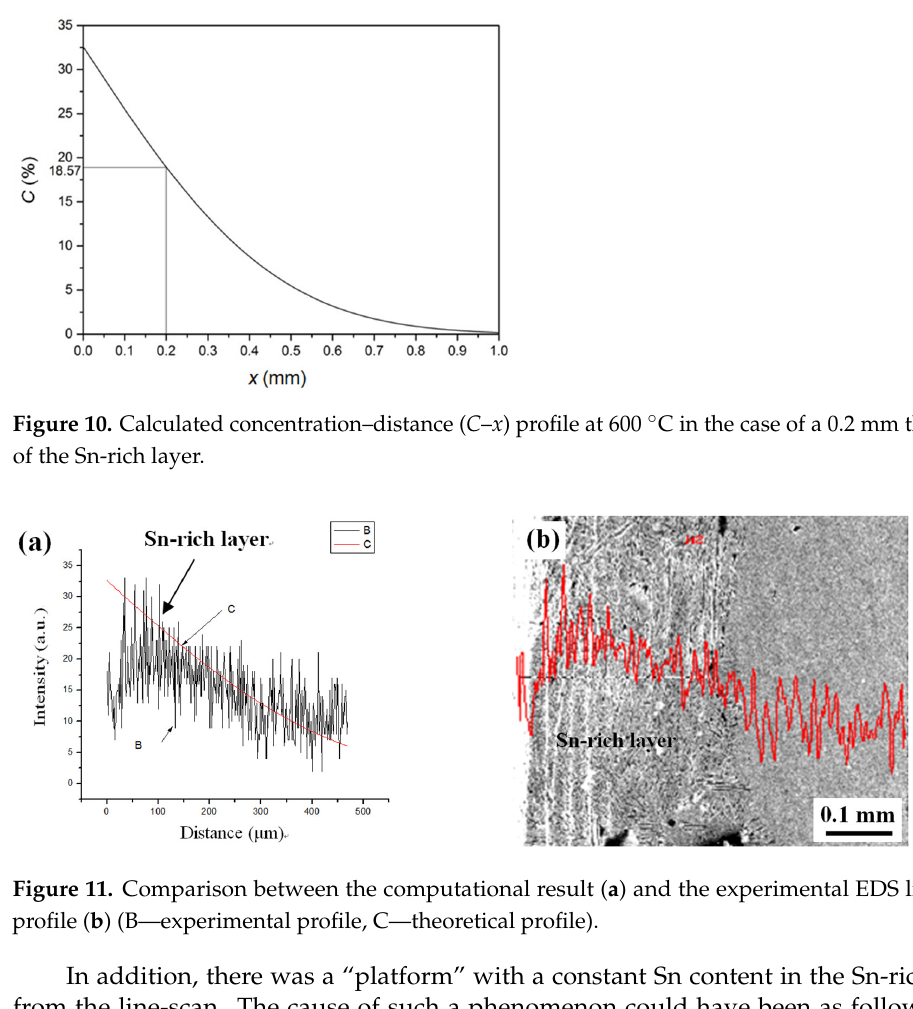
profile ( b ) (B—experimental profile, C—theoretical profile).